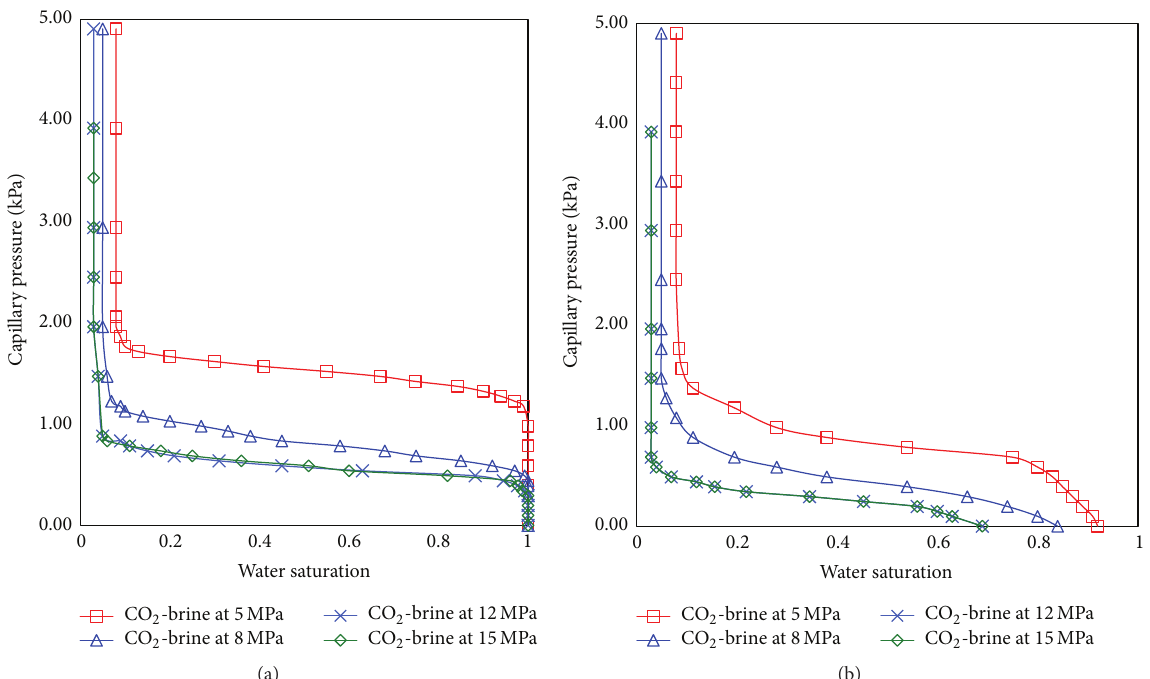
Figure 3: Capillary pressure-water saturation curve of CO 2 -brine at 1M NaCl. (a) Drainage and (b) imbibition.